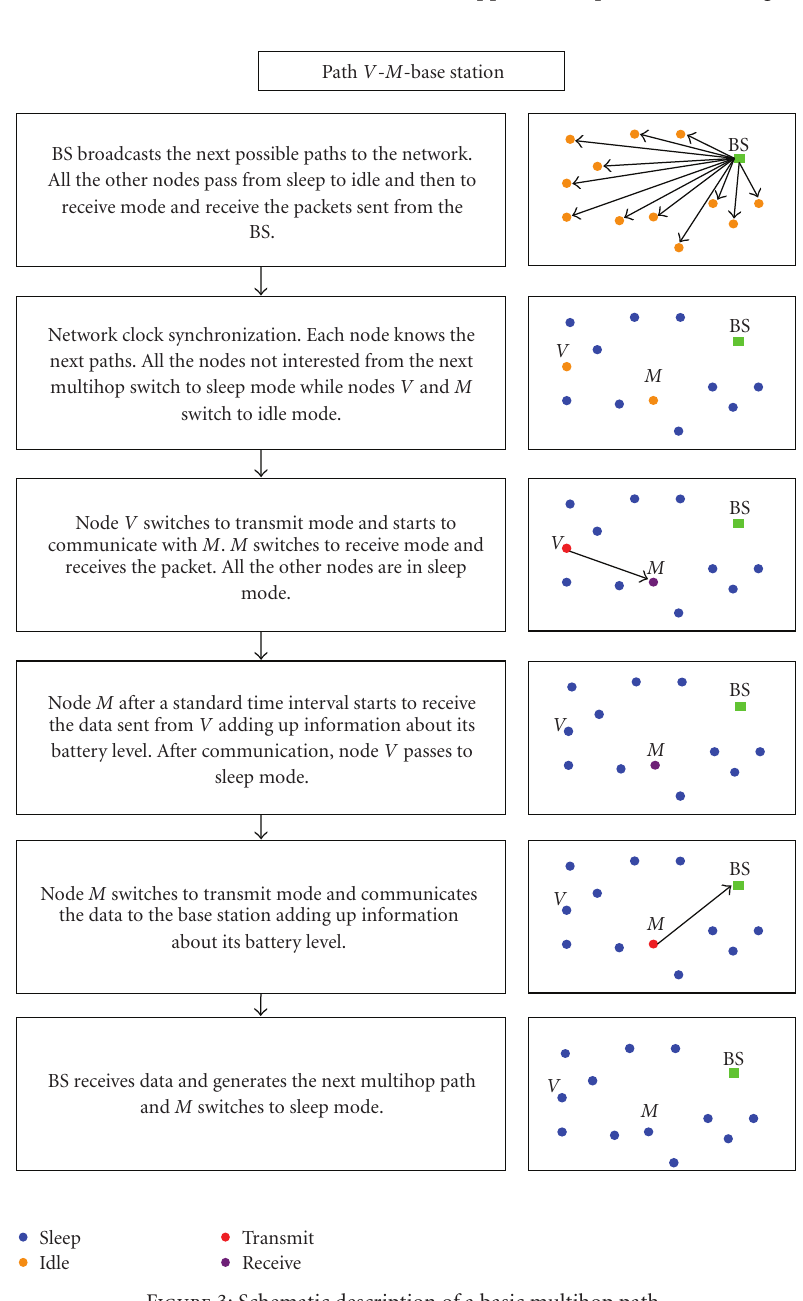
Figure 3: Schematic description of a basic multihop